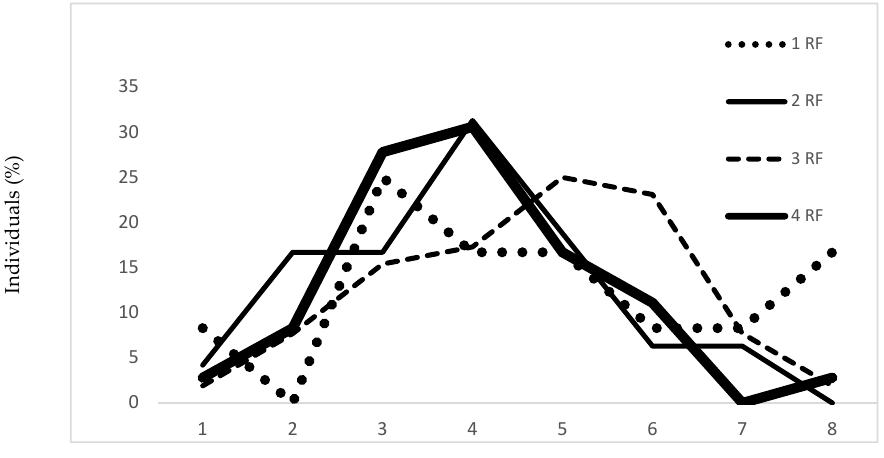
Figure 3. Frequencies of homozygous recessive characteristics in CAD patients regarding number of risk factors. RF: Risk factors; 1 RF: N = 12 (8.1%); 2 RFs: N = 48 (32.4%); 3 RFs: N = 52 (35.2%); 4 RFs: N = 36 (24.3%).